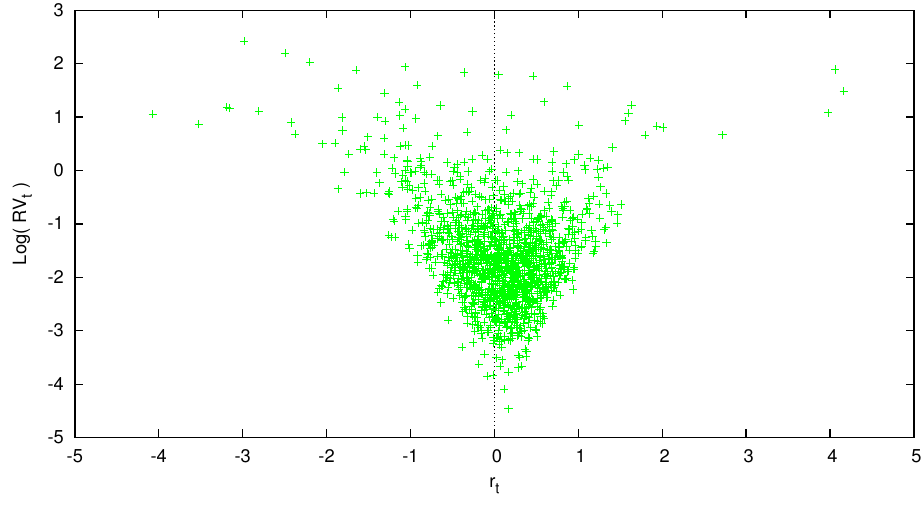
Figure 1. Excess return versus log ( RV t )